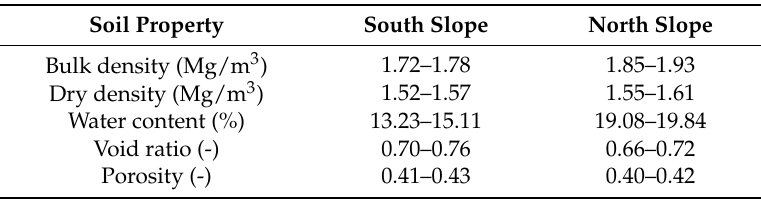
Table 5. Soil properties of materials sampled after construction of the embankment at the two monitored slopes (South and